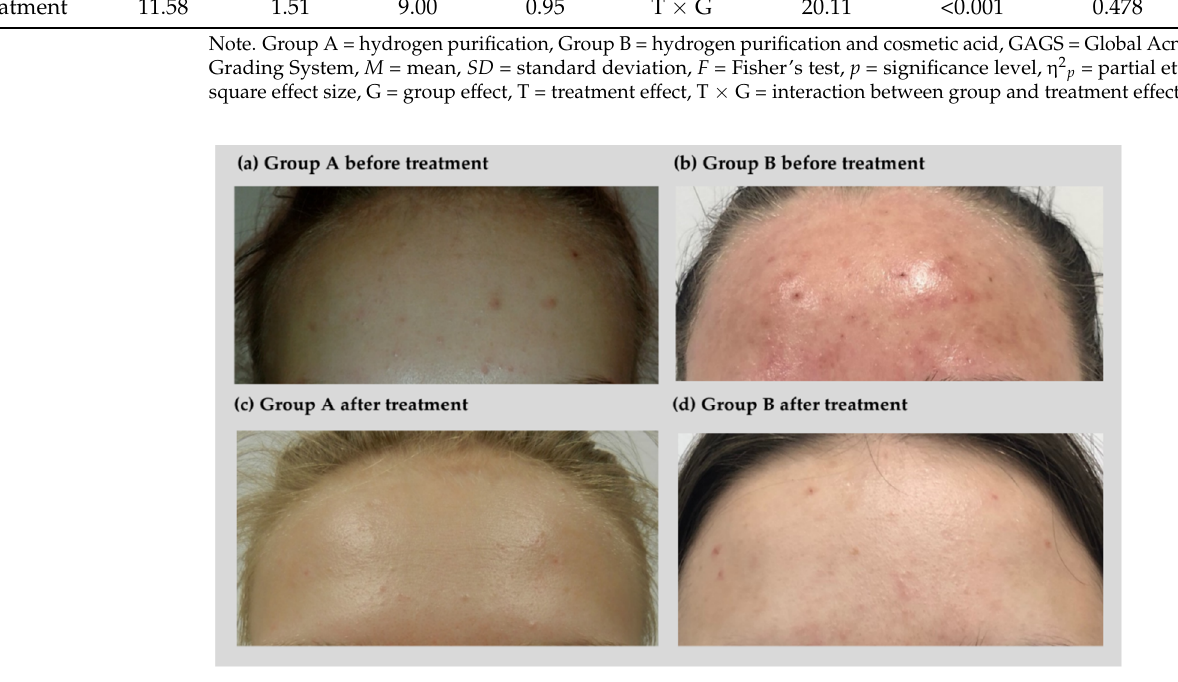
Figure 2. Effect of treatment on acne severity in a patient from group A before ( a ) and after treatment ( c ) , group B before ( b ) and after treatment ( d ).